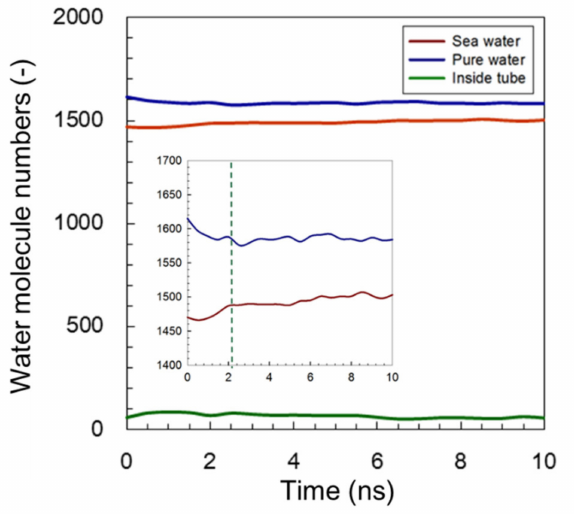
Figure 4. Time course of the number of water molecules during FO simulation using a modified C3deOAmBEr channel ( d = 12 Å). Inserted figure shows the enlarged vertical